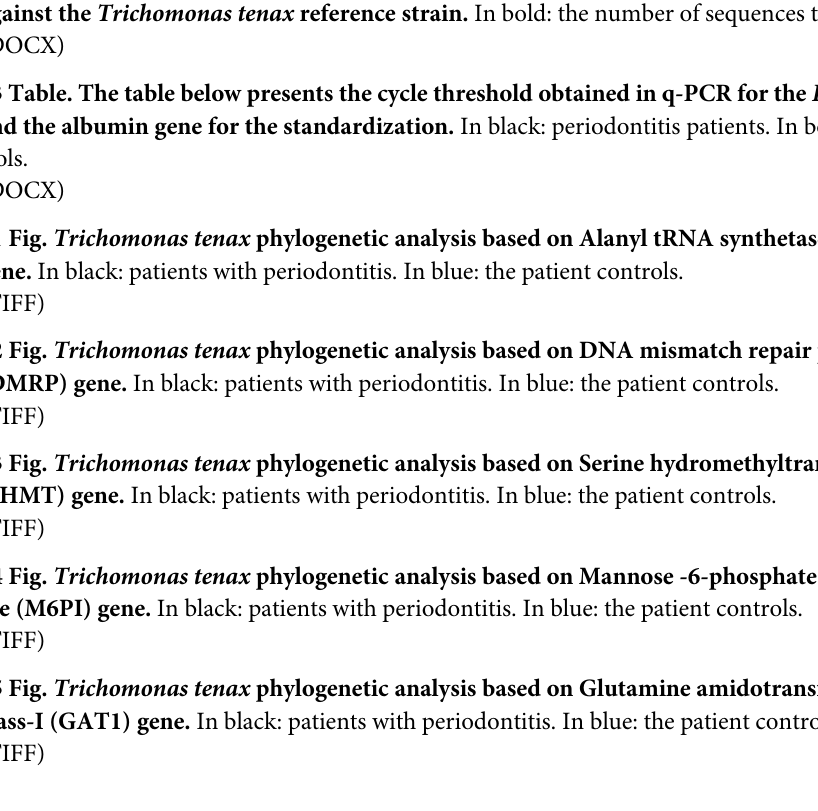
S2 Table. Sequence types of Trichomonas tenax based on single-nucleotide polymorphism against the Trichomonas tenax reference strain. In bold: the number of sequences types.